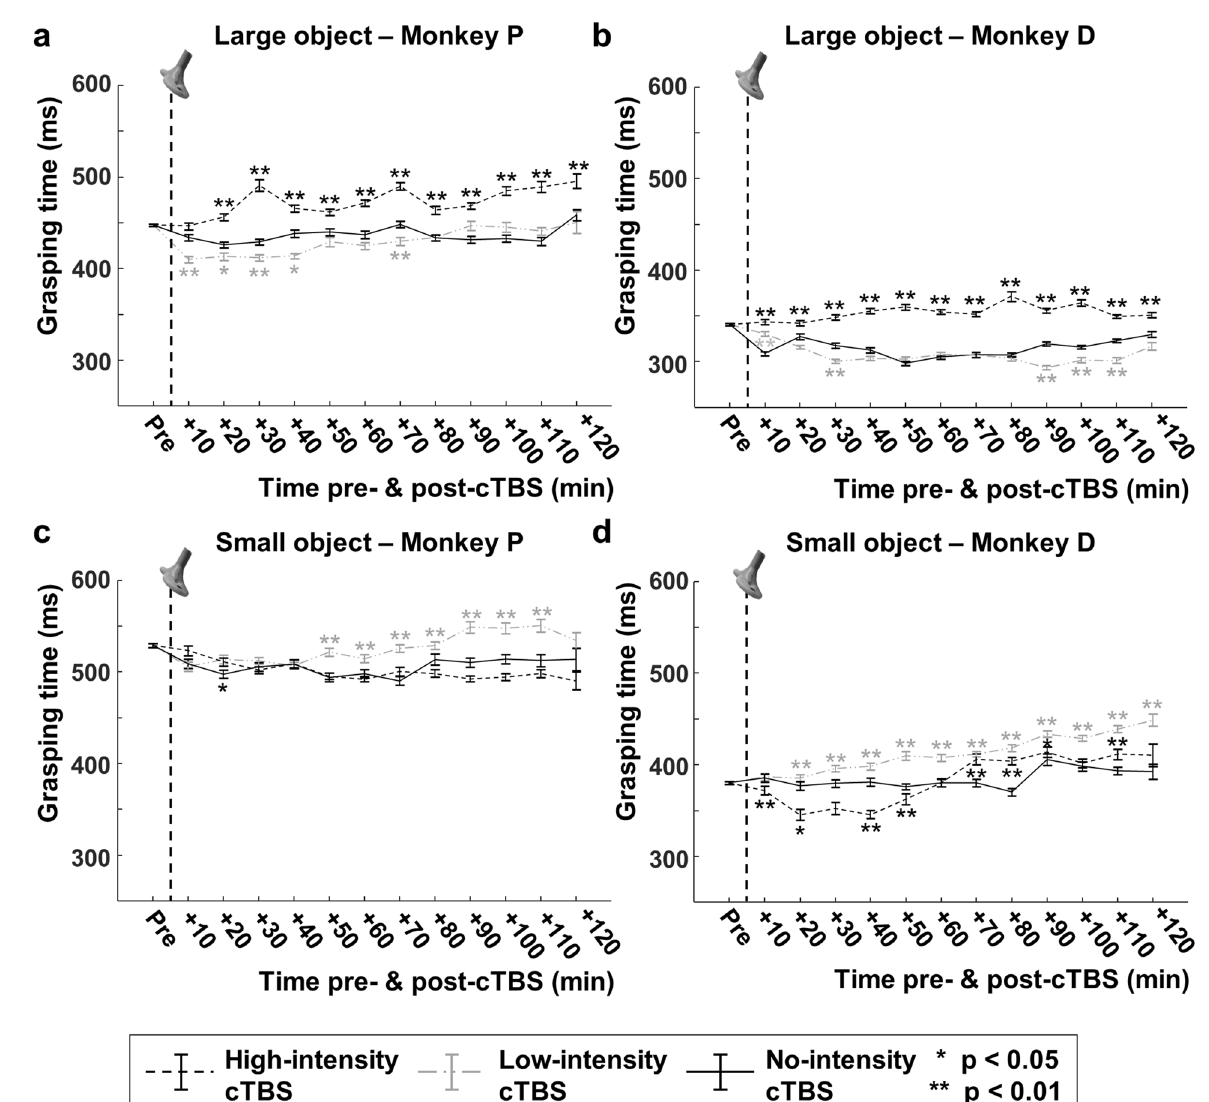
Figure 2. cTBS effect on grasping time. ( a , b ) Normalized grasping times for high- (dashed black line), low- (dashed grey line) and no-intensity (solid black line) cTBS as a function of time, for the large object for monkey P ( a ) and monkey D ( b ). Grasping times of minimally 1700 trials were averaged in time-epochs of 10 min. ( c , d ) Grasping times for the small object for monkey P ( c ) and D ( d ); same conventions as in ( a , b ). Asterisks indicate statistical significance (two-sided Wilcoxon Ranksum test, *: p < 0.05, **; p < 0.01). The vertical dashed line represents the stimulation time